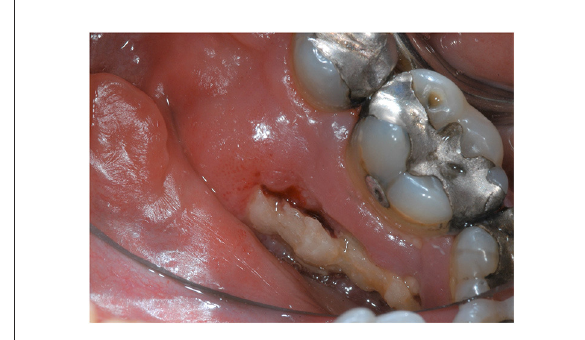
FIGURE1 A 57-year-old male patient, diagnosed with HPV positive T2N2c squamous cell carcinoma of left base of the tongue and treated with definitive chemoradiation (6996cGy in 33 fractions), developed a spontaneous exposed bone measuring 1.5 × 0.5 cm in the lingual posterior mandible adjacent to right mandibular first and second molars, consistent with Notani Stage II ORN. The exposed bony edges were sharp causing irritation to adjacent soft